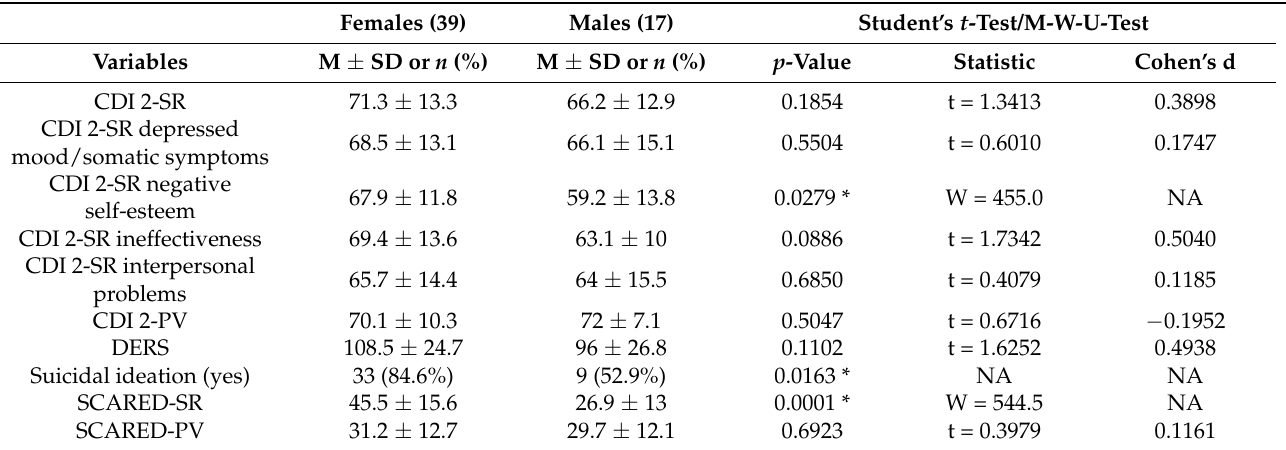
Table 2. Between-group statistical comparisons of clinical variables in depressed females versus depressed males. Females (39) Males (17) Student’s t